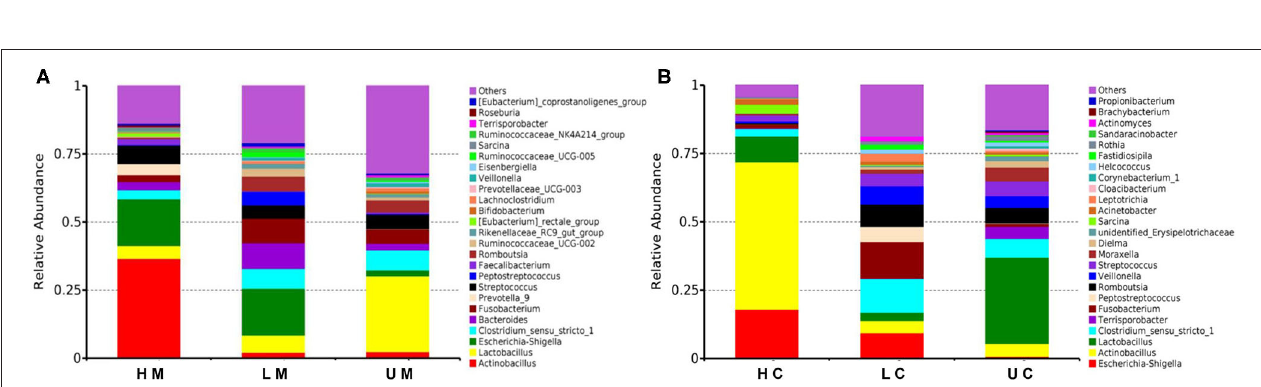
FIGURE 3 | Histogram of the dominant genera in jejunal mucosa (A) and jejunal content (B) microbiome samples from the uninfected, low viral load, and high viral load groups.